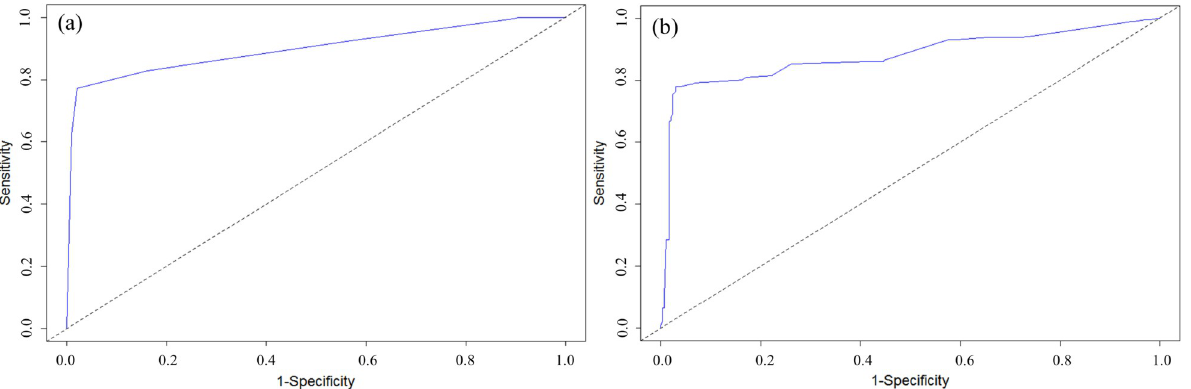
Fig 8. Receiver Operating Curve (ROC) for the validation dataset for classification inference tree model (a), and logistic regression (model 7) (b). Sensitivity (y-axis) describes the proportion of classifiers that are correctly predicted and specificity is the proportion of classifiers that are falsely predicted. AUC is the area under the receiver operating curve. A dash black line is a reference